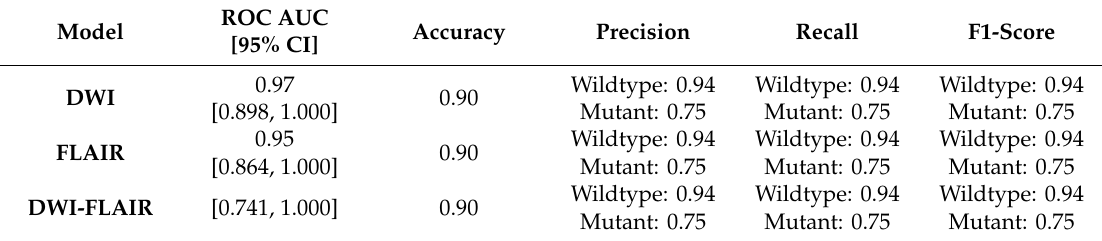
Table 3. Receiver operating characteristic Area under the Curve (ROC AUC), Accuracy, Precision, Recall, and F1-Score of Trained XGBoost